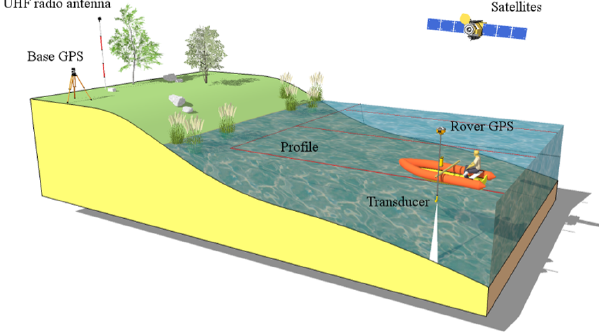
Figure 3. Integrated measuring system – combination of GPS-RTK and a sonar.